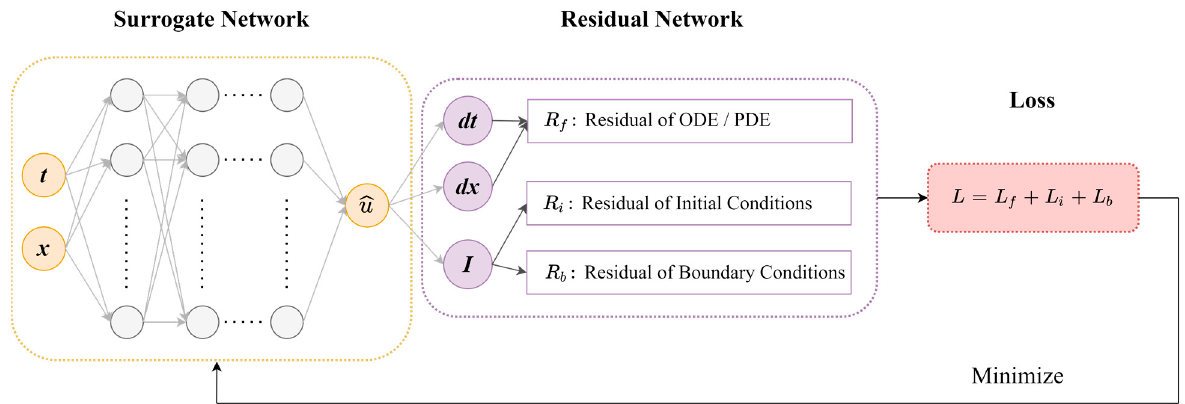
Figure 1. Schematic of a physics-informed neural network (PINN). A fully connected neural network with time and space inputs (𝑡, 𝑥) is constructed to approximate the solutions of 𝑢(cid:3548)(𝑡, 𝑥) , which is then used to calculate the residual loss, ℒ . The residual loss comprises the differential equation’s residual ℒ (cid:3033) , the initial condition’s residual ℒ (cid:3036) , and the boundary condition’s residual ℒ (cid:3029) . The derivatives of 𝑢(cid:3548) are computed by automatic differentiation. The parameters of the fully connected network are trained using gradient-descent methods based on the back-propagation process.